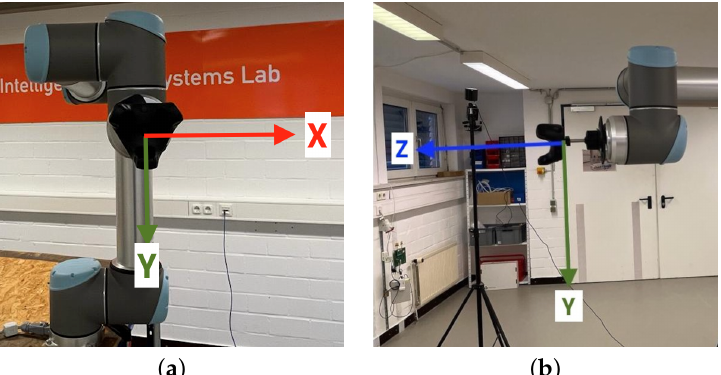
Figure 2. Universal Robots UR10 tool coordinate system with TCP adjusted to mounted VIVE Tracker (3.0) base center: ( a ) Frontal view with X- and Y-axis. ( b ) Side view with Y- and